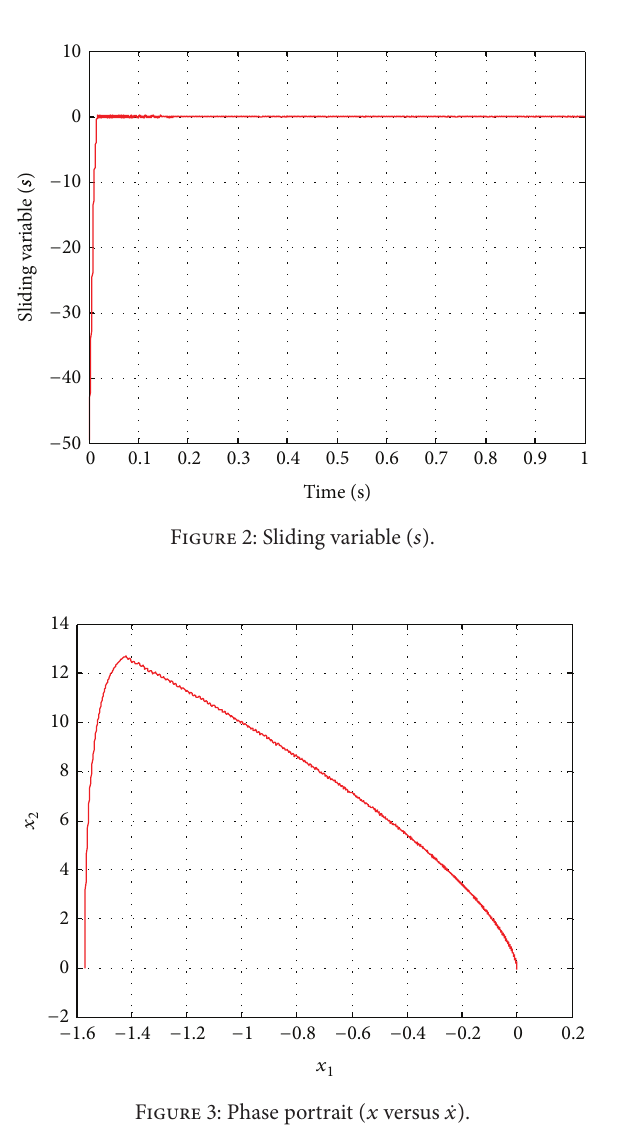
(18), 𝑝 = 1/2 is obtained for the minimum relaxation time.